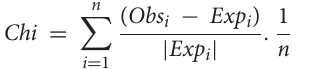
FIGURE 1 | timestamps of the Gesture Trajectory Extrema (GTEs) calculated from the envelope trace: solid lines indicate onset and offset GTEs; dotted lines, minima; dashed-and-dotted lines, absolute maximum and dashed lines indicate last maximum. Right: normalized GTE position plots of the zebra finch song. The GTE timestamps in the song and the GTE indices are normalized. The blue line shows the best fit using ordinary least squares. The gray area corresponds to the 95% confidence interval (see Methods). (B) Left top: sound of a canary song. Labels Ph1–Ph6 and bars indicate repetitions of one syllable, also called phrases. Left middle, left bottom, and right panel as in (A) . (C) Left top: sound of zebra finch motif M1 from (A) . Letters a–j and bars indicate individual syllables. Left middle, left bottom, and right panel as in (A) . (D) Left top: sound of a canary pseudo-motif. Letters a–f and bars indicate unique instances of the syllables in each phrase showed in (C) . Left middle, left bottom, and right panel as in (A)